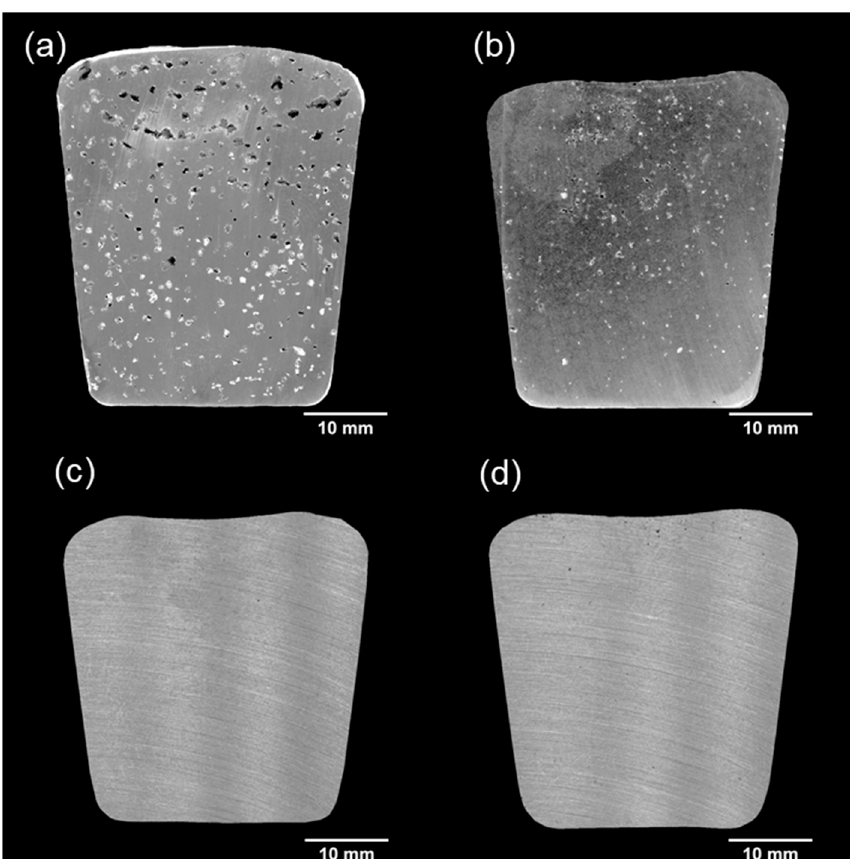
Figure 6. Porosity of the vacuum RPT samples obtained ( a ) before degassing; ( b ) after rotary degassing; ( c ) after HSMC 0.1 L/min–3000 rpm degassing; ( d ) after HSMC 1 L/min–6000 rpm degassing. Adapted from [24,32]. Reprinted with permission from [32]. Copyright 2022 Elsevier.